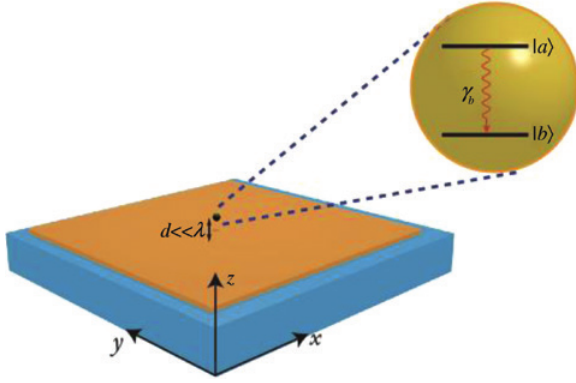
Figure 7: Dipole-mirror interface. An atomic dipole (i.e. two-level atom with excited state | a > and ground state | b > ) located in the vicinity of a mirror. Depending on the orientation of the dipole moment, the atomic dipole exhibits enhanced or suppressed emission